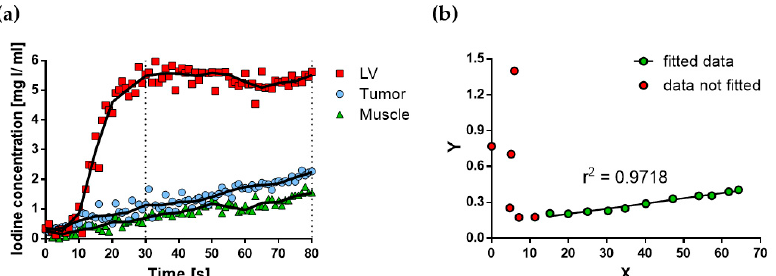
Figure 4. Quantitative evaluation of the DCE planar images of the subcutaneous C6 glioma model. ( a ) Time–C I curves of the left ventricle (LV), tumor, and muscle, during the continuous infusion of a clinical contrast agent. Original data are shown (symbols), as well as smoothed data (solid lines). ( b ) Patlak analysis of the tumor data. Volume transfer constant (K trans ) and relative blood volume (rBV) were quantified as the slope and the intercept, respectively, of the fitted line to data in the time interval of 30–80 s (green circles).